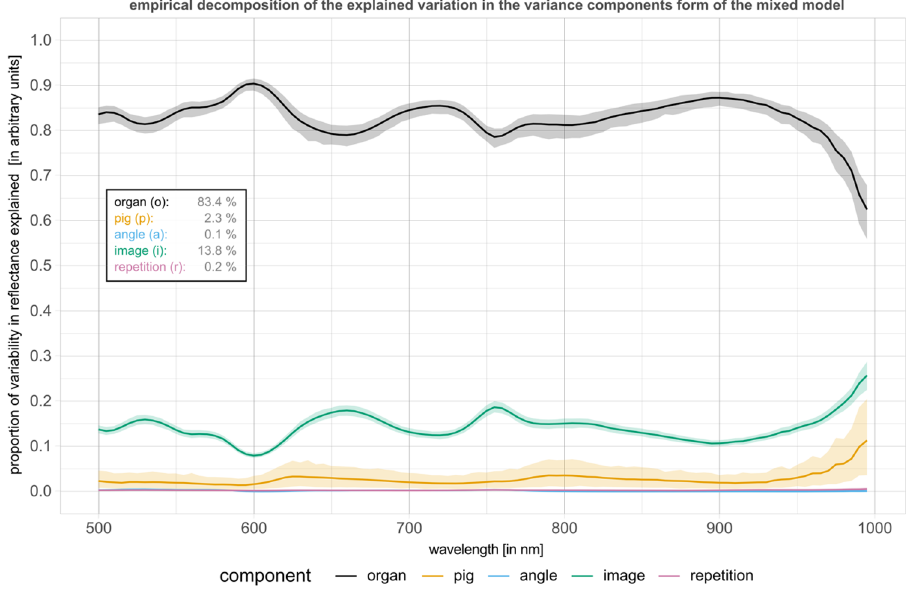
Figure 3. Sources of variation of hyperspectral data. (Proportion of) variability in reflectance explained by each factor using linear mixed models. Factors include “organ”, “pig”, “angle”, “image” and “repetition”. For each recorded wavelength, an independent linear mixed model was fitted with fixed effects for the factors “organ” and “angle” as well as random effects for “pig” and “image”. Variation across repetitions was given by the residual variation. The greater the proportion of variability for “organ”, the more reflectance can be seen as organ- characteristic. Shaded areas depict 95% (pointwise) confidence intervals based on parametric bootstrapping. The numbers represent the median across